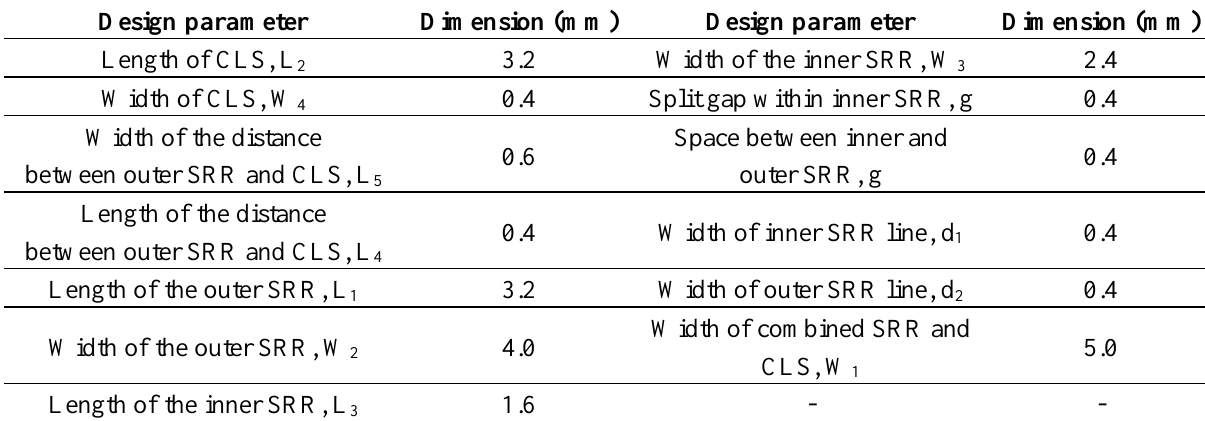
Figure 1. ( a ) Front view of the modified SSR unit cell with CLS and ( b ) simulation geometry. Table 1. Design parameters of the metamaterial unit